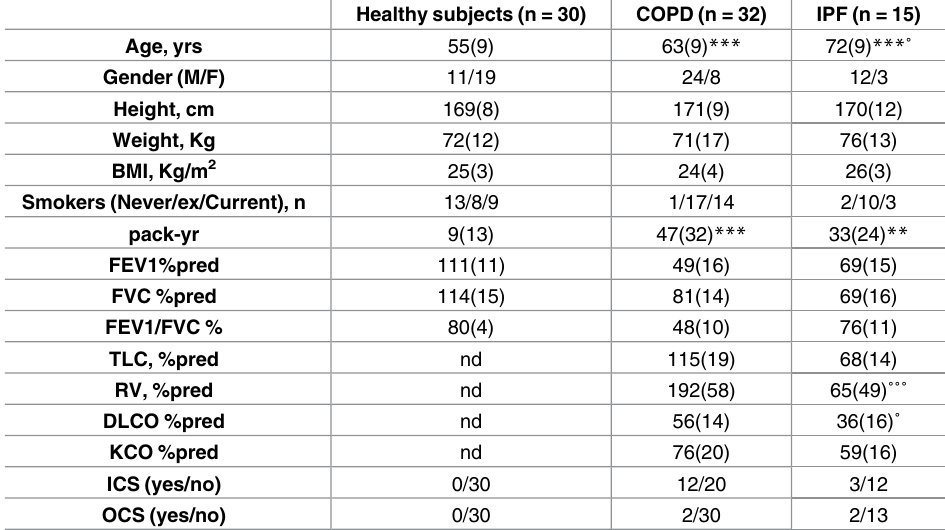
Table 2. Subject